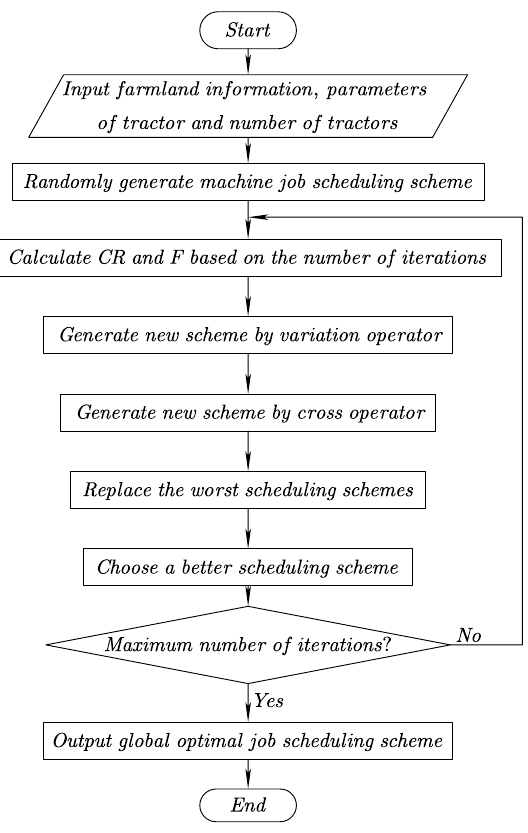
Figure 4. Flowchart of improved differential evolution algorithm.